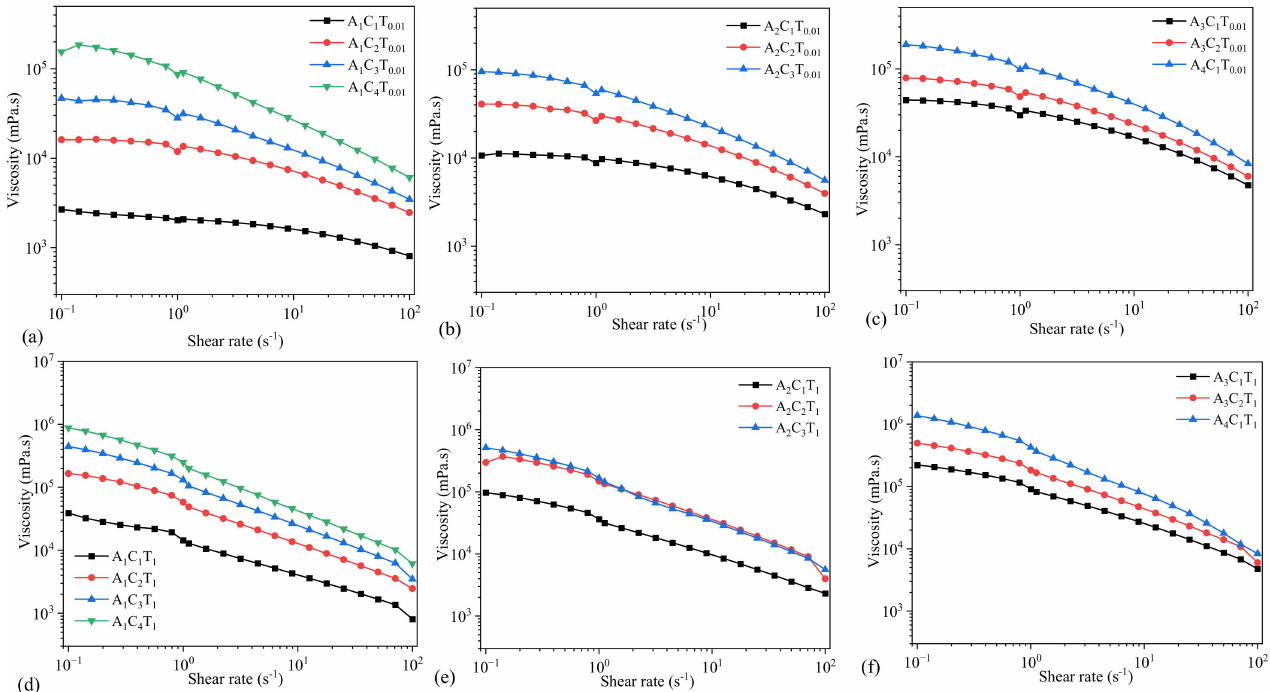
Figure 5. Viscosity of compositions composed with various percentages of alginate (1–4%) and CMC (1–4%) with ( a – c ) 0.01% of TO-NFC and ( d – f ) 1.0% of TO-NFC.